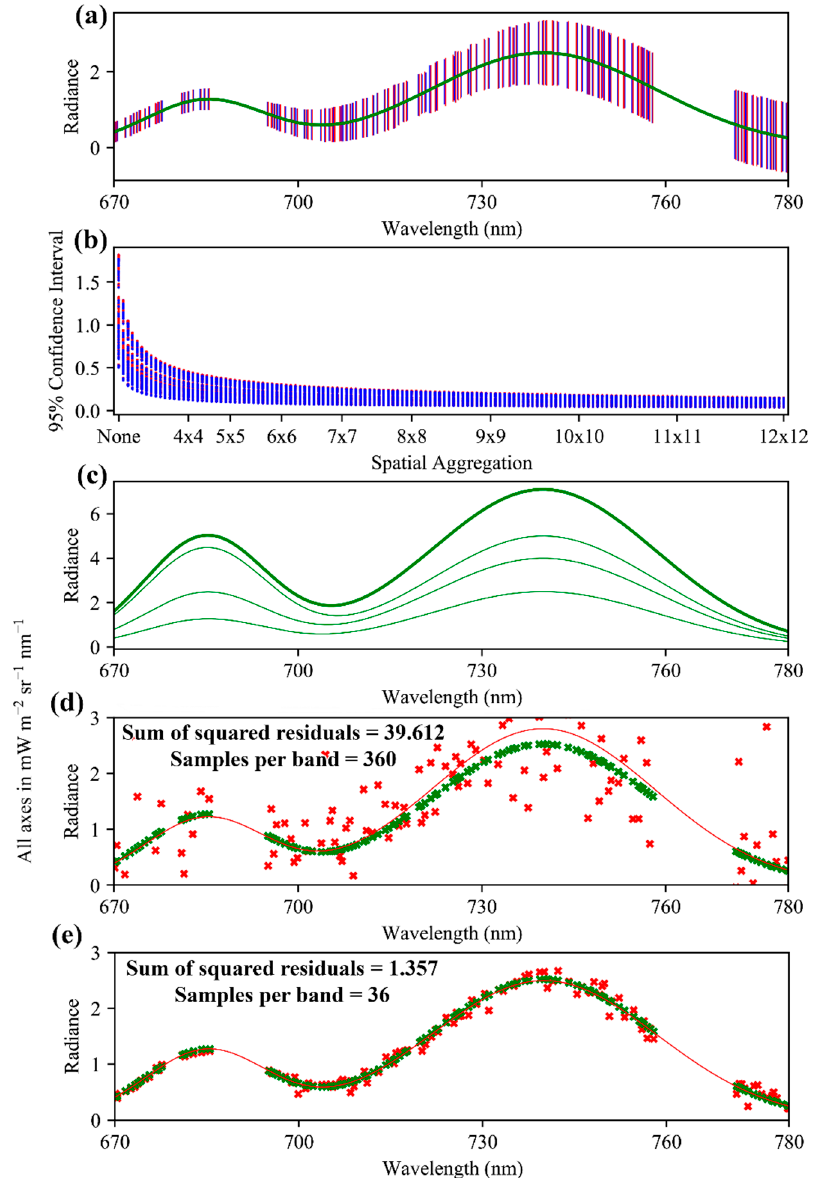
Figure 22. ( a ) Expected variation in valleys (red lines) and peaks (blue lines) relative to a simulated SIF signal (green line); ( b ) expected confidence intervals for valleys (red dots) and peaks (blue dots) at different spatial aggregation factors (functionally, sample sizes); ( c ) example simulated SIF functions (thin green lines) and their sum (thick green line); ( d ) indirect SIF retrievals (red x) fitted to a SIF signal (red line). The true SIF value in each band (green x) is also shown. Note that the vertical axis matches the range of (e) for the sake of comparing the fitted functions, and therefore does not show all of the residuals; and ( e ) direct SIF retrievals from valleys (red x) fitted to a SIF signal (red line). The true SIF value in each band (green x) is also shown.